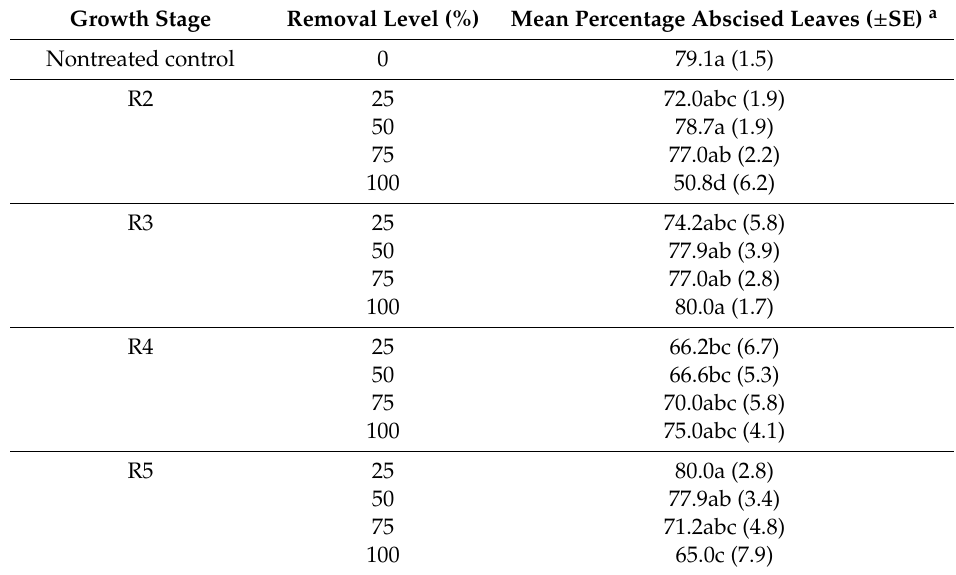
Table 1. E ff ect of fruit removal plant stage on mean percentage of normally abscised leaves during